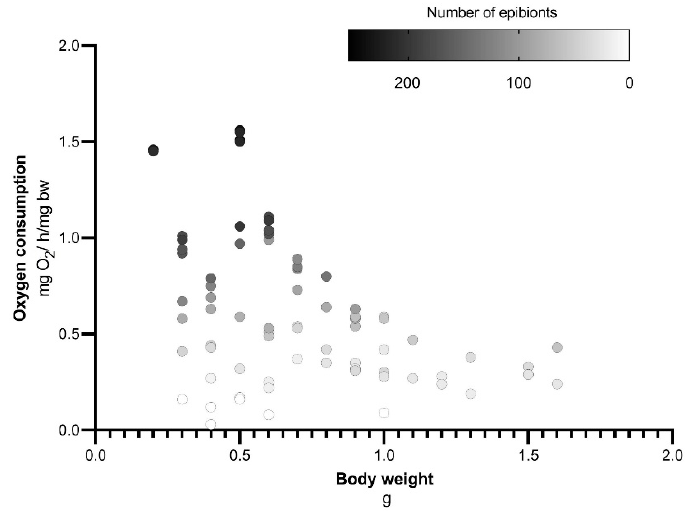
Figure 4. Oxygen consumption and body weight of the crayfish with different number of ciliates attached to the gills.